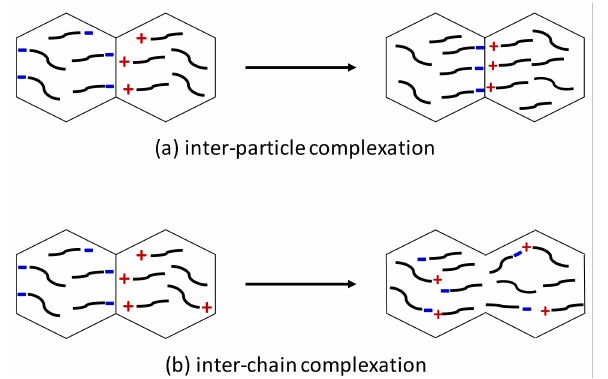
Figure 6. Schematic view of ionic complexation step at ( a ) inter-particle level and ( b ) inter-chain